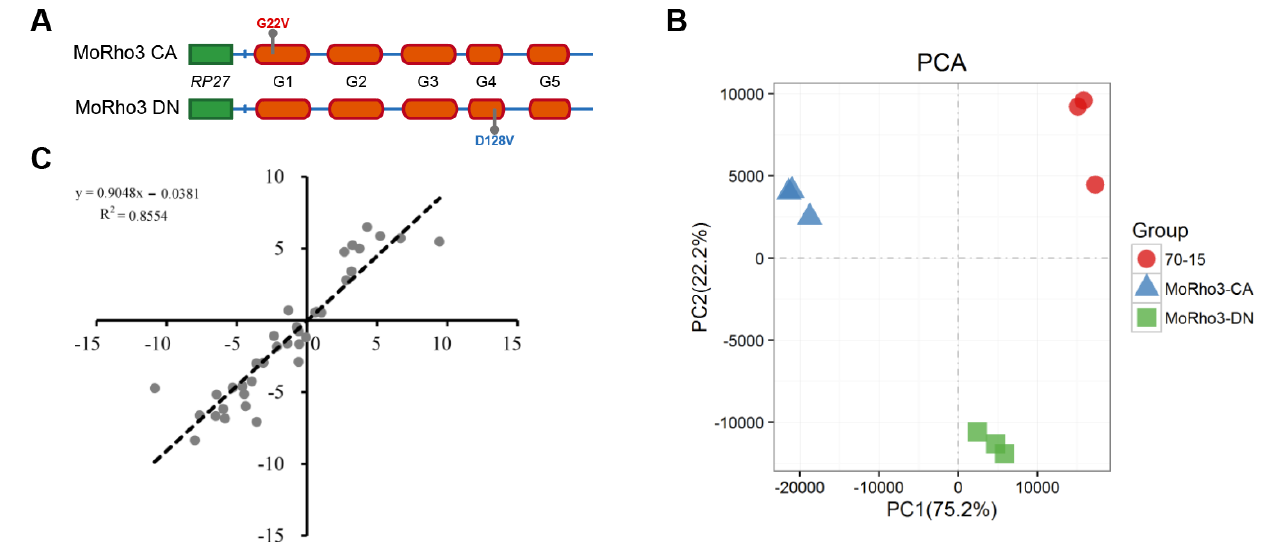
Figure 1. Transcriptome sequencing of Constitutively Active (CA) and Dominant-Negative (DN) mutants of MoRho3. ( A ) Schematic showing generation of CA and DN mutants of MoRho3. ( B ) Principal component analysis of 9 samples based on the expression level of 9,230 genes. ( C ) qRT-PCR validation of reproducibility of gene expression level estimated by RNA-seq.